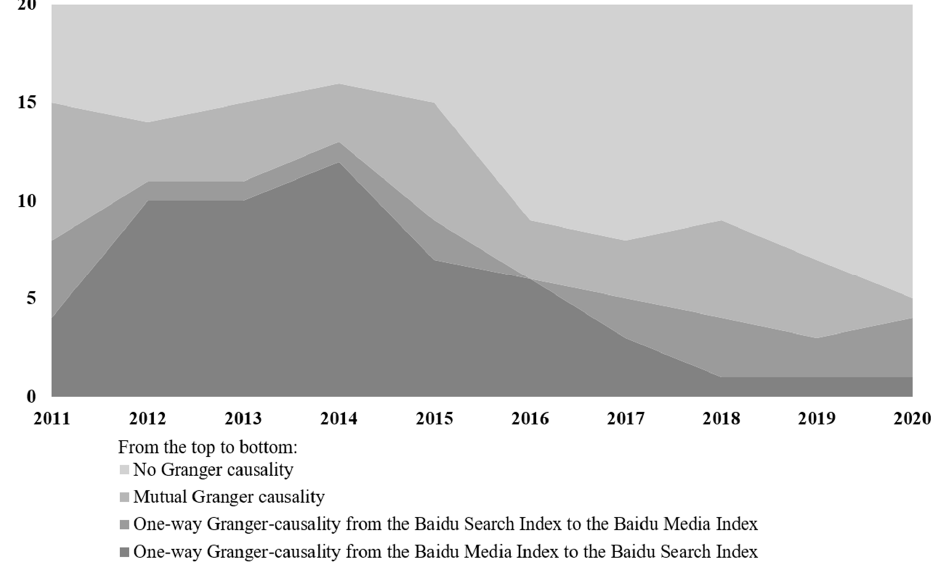
Figure 3. Frequency of occurrence of different Granger-causality